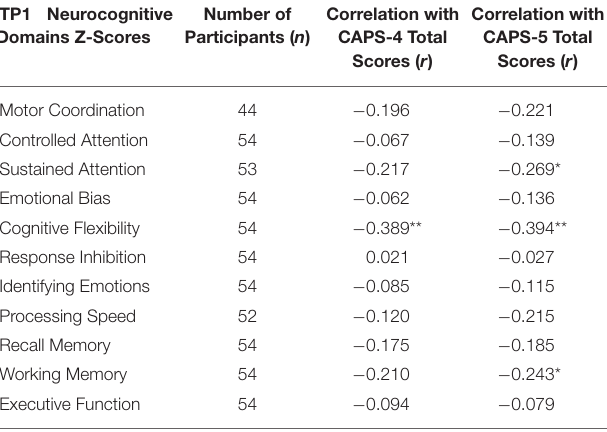
TABLE 1 | Pearson correlations between Study 1 participants’ neurocognitive domains Z-scores at 1 month after trauma (TP1) and PTSD symptom severity at 14 months after trauma